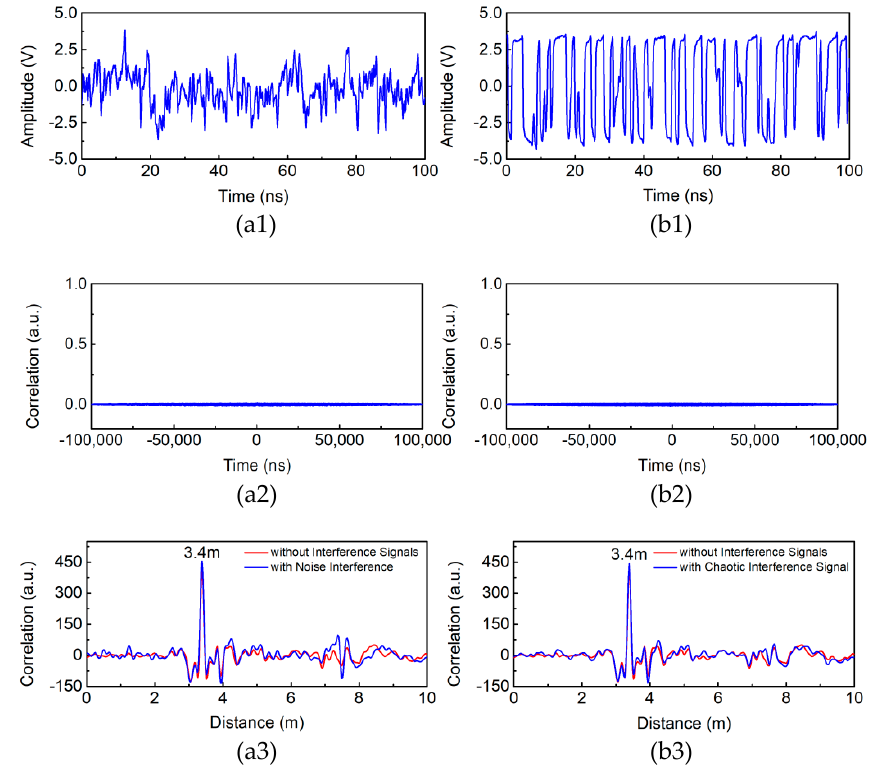
Figure 11. Temporal waveform of ( a1 ) noise and ( b1 ) chaotic interference signal. Crosscorrelation traces of ( a2 ) noise and chaotic reference signal, ( b2 ) chaotic interference signal and chaotic reference signal. Comparison of detection results with and without ( a3 ) noise and ( b3 ) chaotic interference signal.